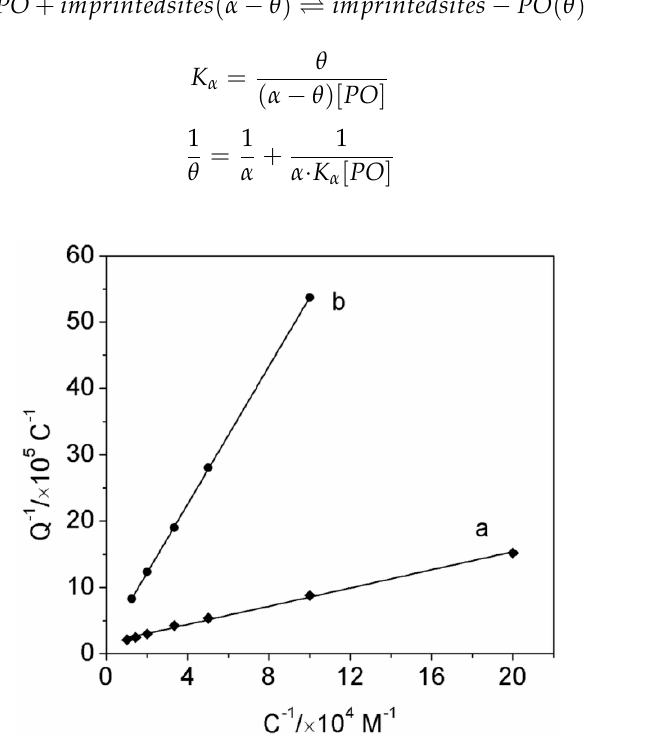
Figure 5. Coulometric analysis of the PO associated with the ( a ) imprinted and ( b ) nonimprinted PATP/AuNPs/SPCE upon interaction of the electrode with different bulk concentrations of PO for 10 min.